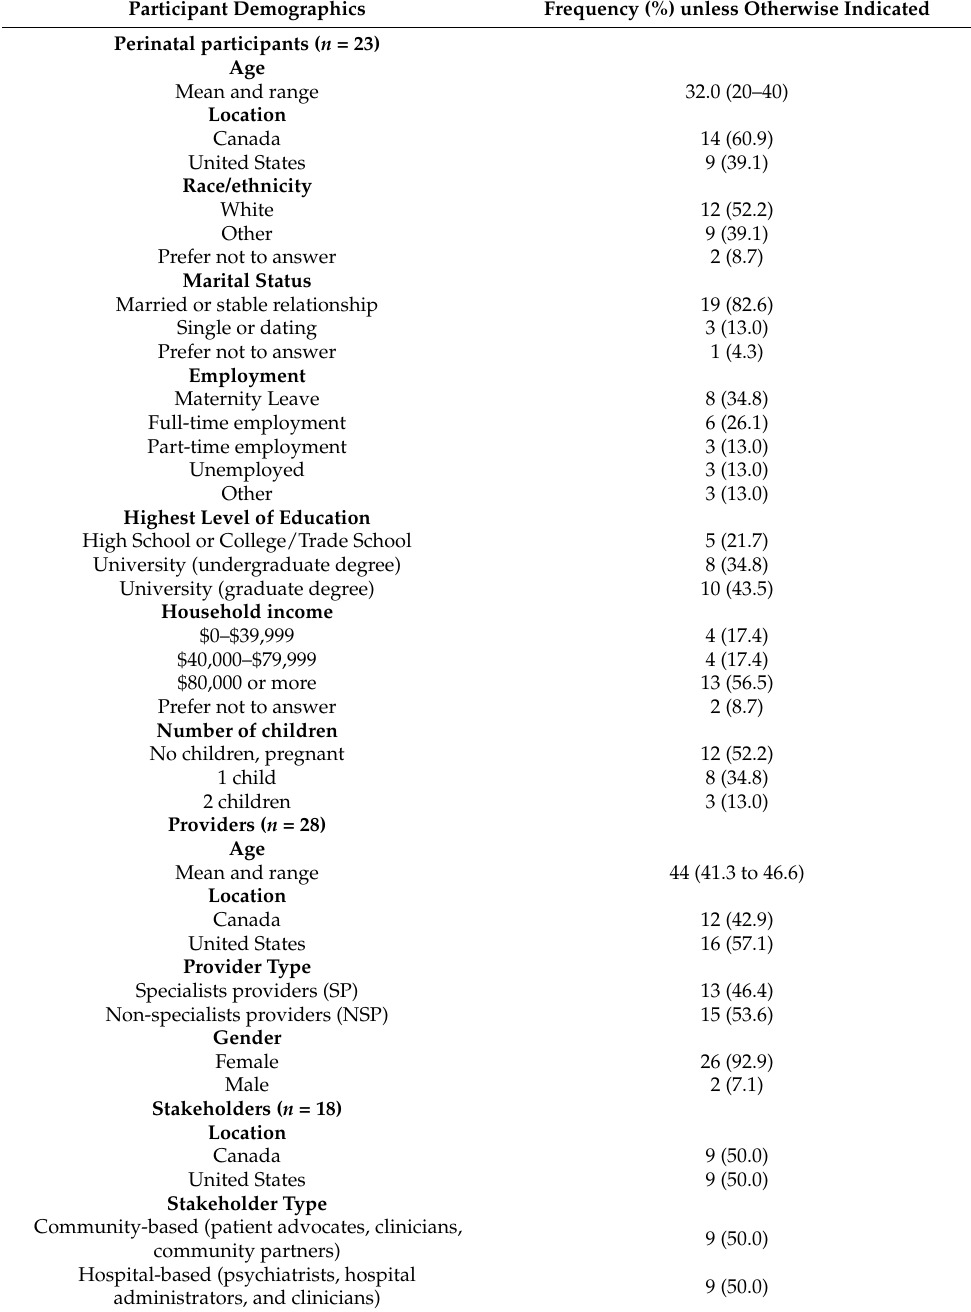
Table 1. Participant demographic